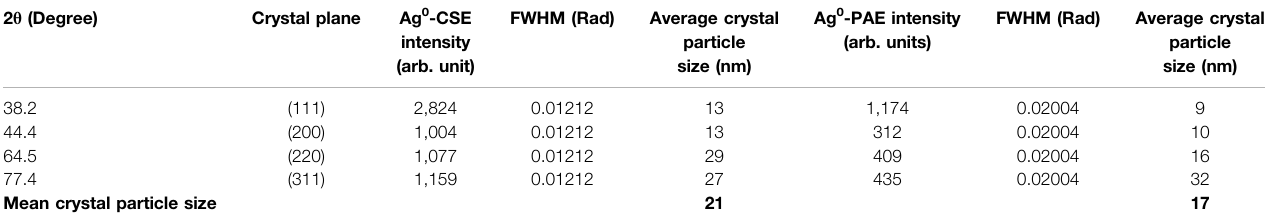
TABLE 2 | 2 θ values with their corresponding miller ’ s incidences, peak intensity, and average crystal size of CSE and PAE biologically synthesized nanoparticles. 2 θ (Degree) Crystal plane Ag 0 -CSE FWHM (Rad) Average crystal intensity (arb. unit)